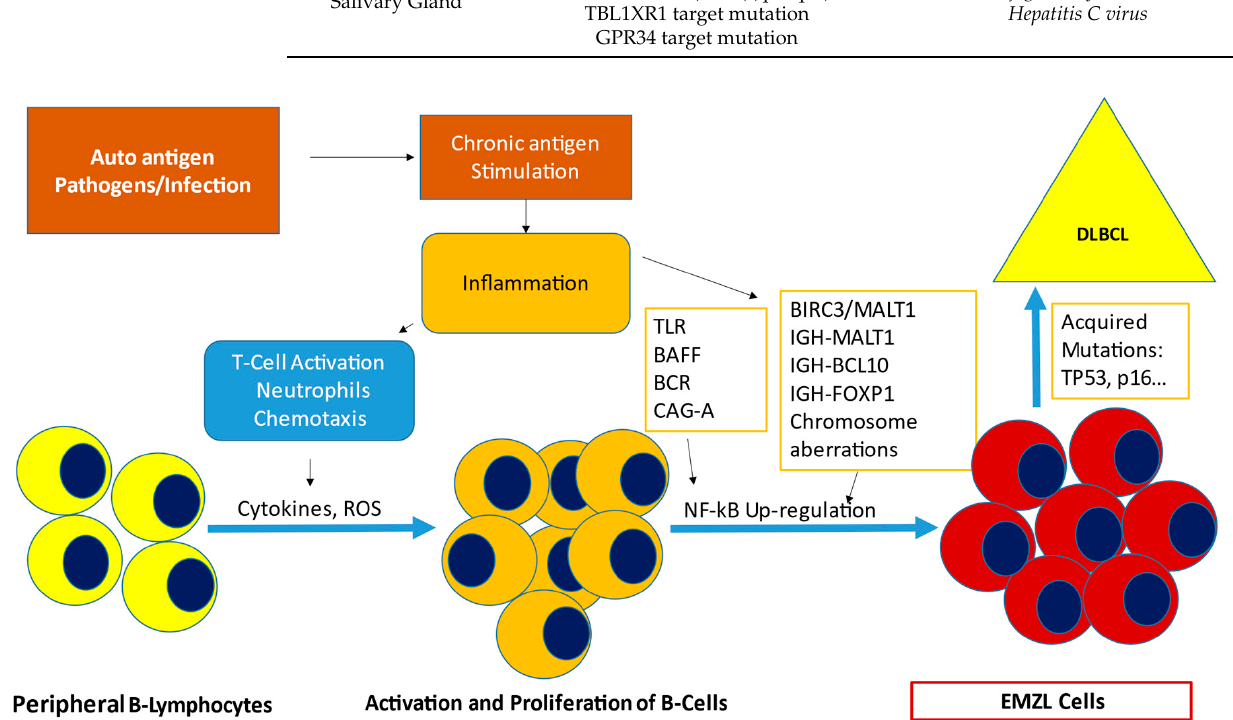
Figure 1. Etiopathogenesis of Extranodal Marginal Zone Lymphoma. Chronic antigen stimulation is given by associated infections ( H. pylori , C. Psittaci , etc.) and/or autoimmune diseases and sustains inflammation. T-Cell activation and Neutrophils chemotaxis are enhanced, producing cytokines and Reactive oxygen species (ROS), which are responsible for peripheral B-Lymphocytes activation and proliferation. Inflammation causes the upregulation of NF-kB pathway, through Toll-like receptors (TLR), B cell receptor (BCR), B-cell activating factor (BAFF), and the exposure of DNA to the damaging effects of ROS. Mutations and Genomic aberrations can occur in this context, promoting tumorigenesis and transformation into Extranodal Marginal Zone Lymphoma (EMZL) cells. Acquired mutations can occur, such as deletions of p53 and or p16, leading to DLBCL transformation. CAG-A, Cytotoxin-associated antigen A; BIRC3/MALT1, t(11;18); IGH-MALT1, t(14;18); IGH-BCL10, t(1;14); IGH-FOXP1, t(3;14); DLBCL, Diffuse Large B-Cell Mutations. Table 1. Site-related pathogens and genetic mutations. EMZL Site-Related Genomic Aberrations, Pathogens, Autoimmune Disorders Localization Genomic Aberrations